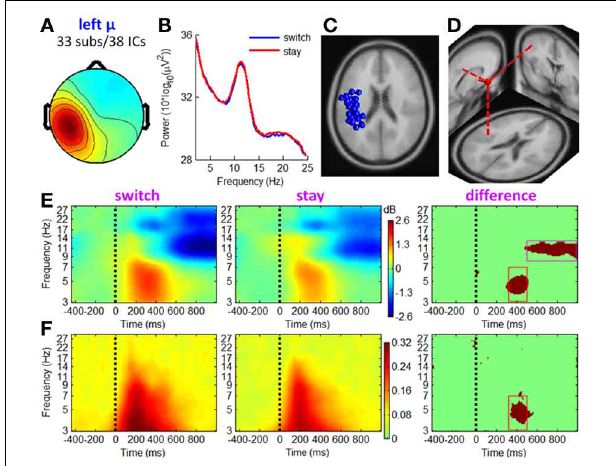
FIGURE 7 | IC properties of left mu rhythm cluster. (A) Mean scalp maps across 38 ICs. (B) Mean power spectra. (C) Equivalent dipole locations of 38 ICs. (D) Mean dipole location and orientation. (E) Mean ERSP image. (F) Mean ITC image. The red and magenta boxes define TF ROIs for single-trial feature extraction.